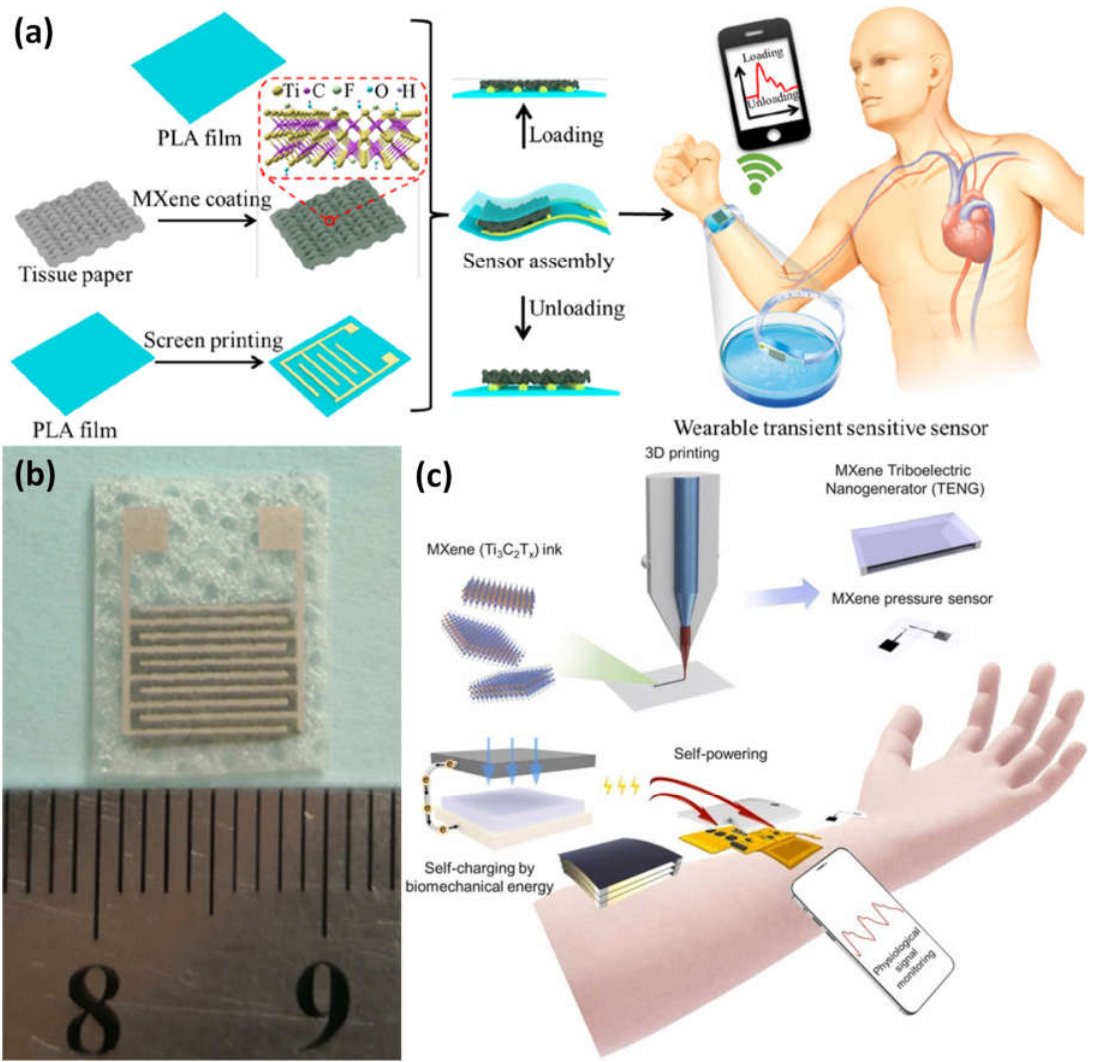
Figure 12. ( a ) Sandwiching a thin sheet of a biodegradable polylactic acid (PLA) and an interdigitated electrode-coated PLA between two porous MXene-impregnated tissue papers to anticipate the potential health condition of patients and serve as a tactile input mapping electronic skin; ( b ) images of the stretchable transient pressure sensor for wearables; ( c ) the suggested, designed, characterized, and verified wearable device for MXene-based, adaptable, and integrated physiological biosignals monitoring for continuous, real-time. Reproduced with permission from references [101,102].